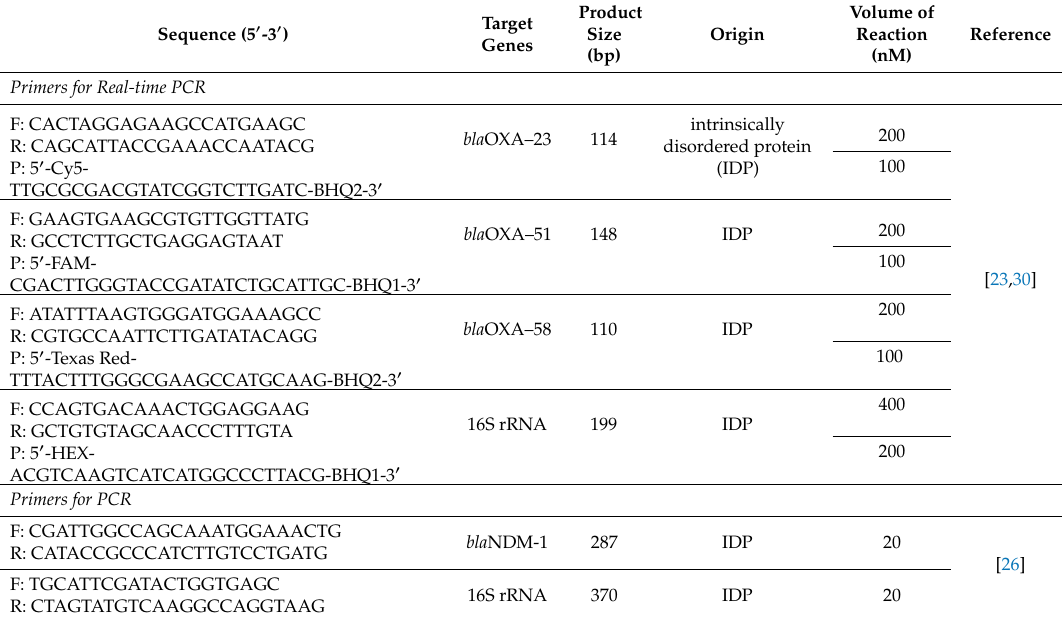
Table 1. Primers and probes were used to detect carbapenemase encoding